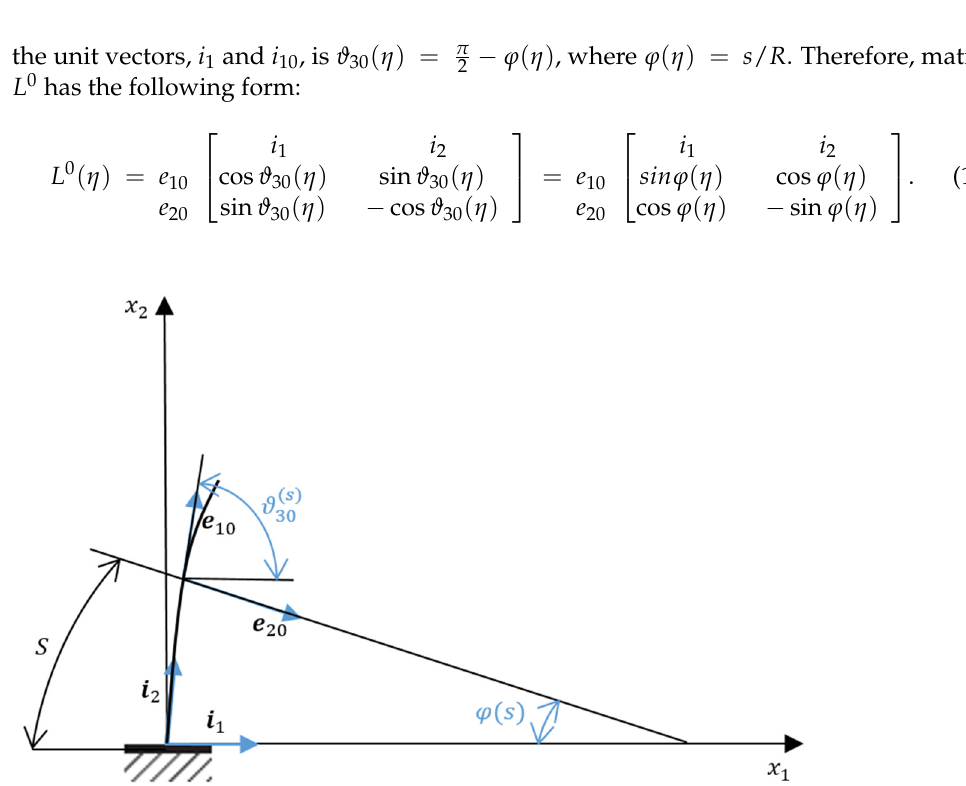
Figure 2. Relationship between the center angle ϕ ( s ) and angle ϑ 30 (s). 3. Applying MSL in the Numerical Method (Matlab) and FEM (Ansys